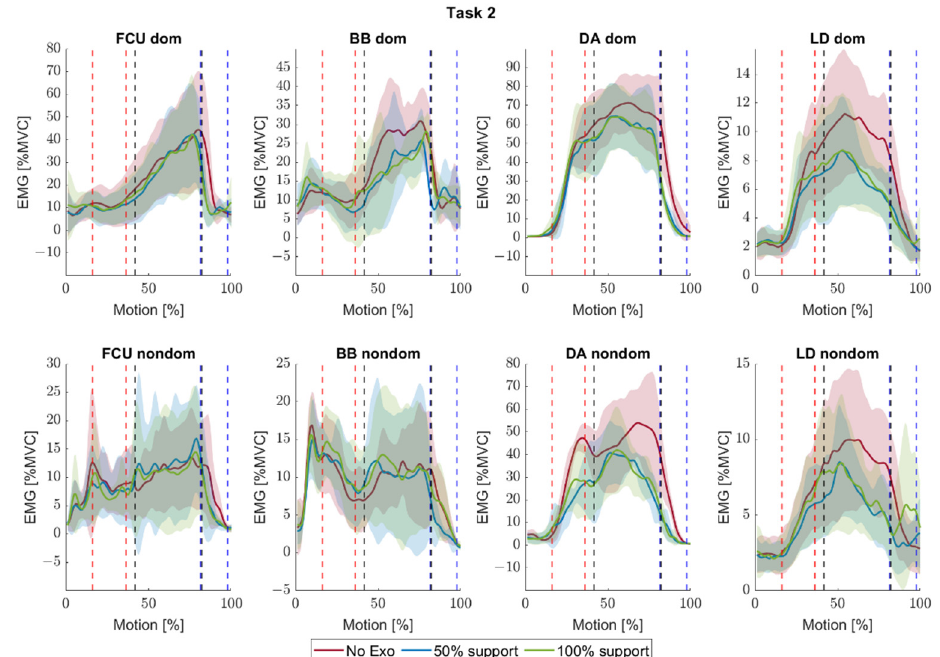
Figure 10. The participants’ average EMG curves during the complete motion sequence, in task T2, under three test conditions. The shadows represent the standard deviations. Three motion phases are marked from left to right on the graphic: (1) arm lifting was between two red dashed lines; (2) screw was between two black dashed lines; (3) arm lowering was between two blue dashed lines.